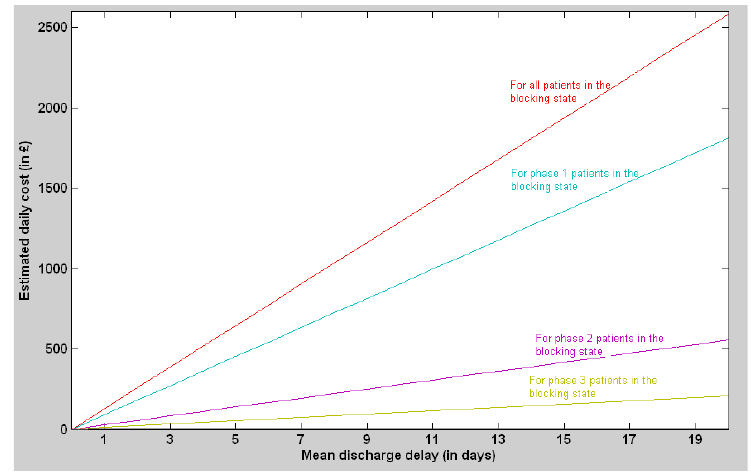
Figure 13. The estimated number of additional beds required in each phase of the stroke care unit with respect to the mean discharge delay (after 1000 days).